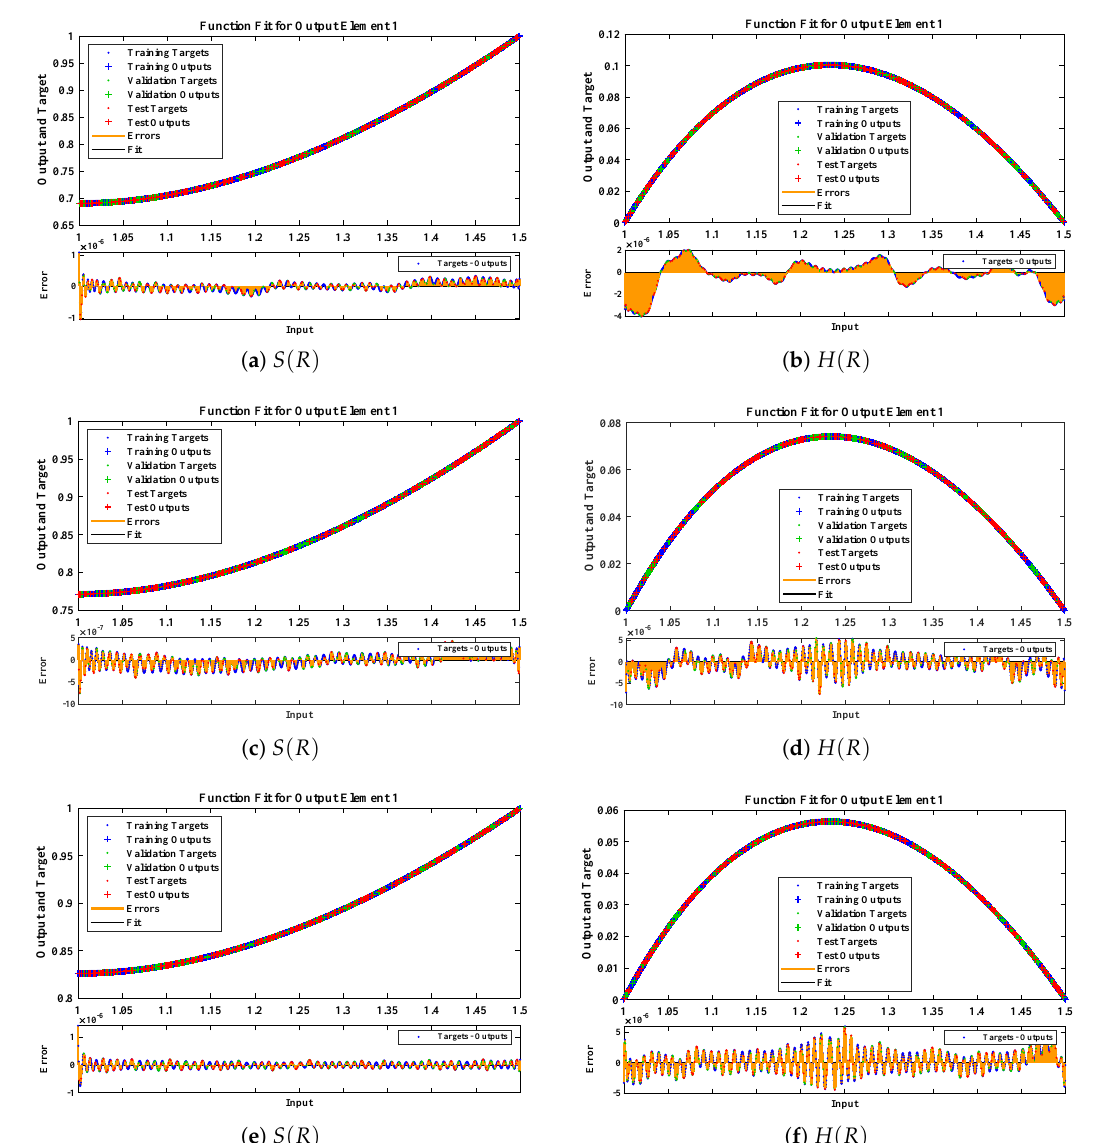
Figure 8. Comparison of approximate solutions obtained by NNs–LMT with numerical solution for different cases of